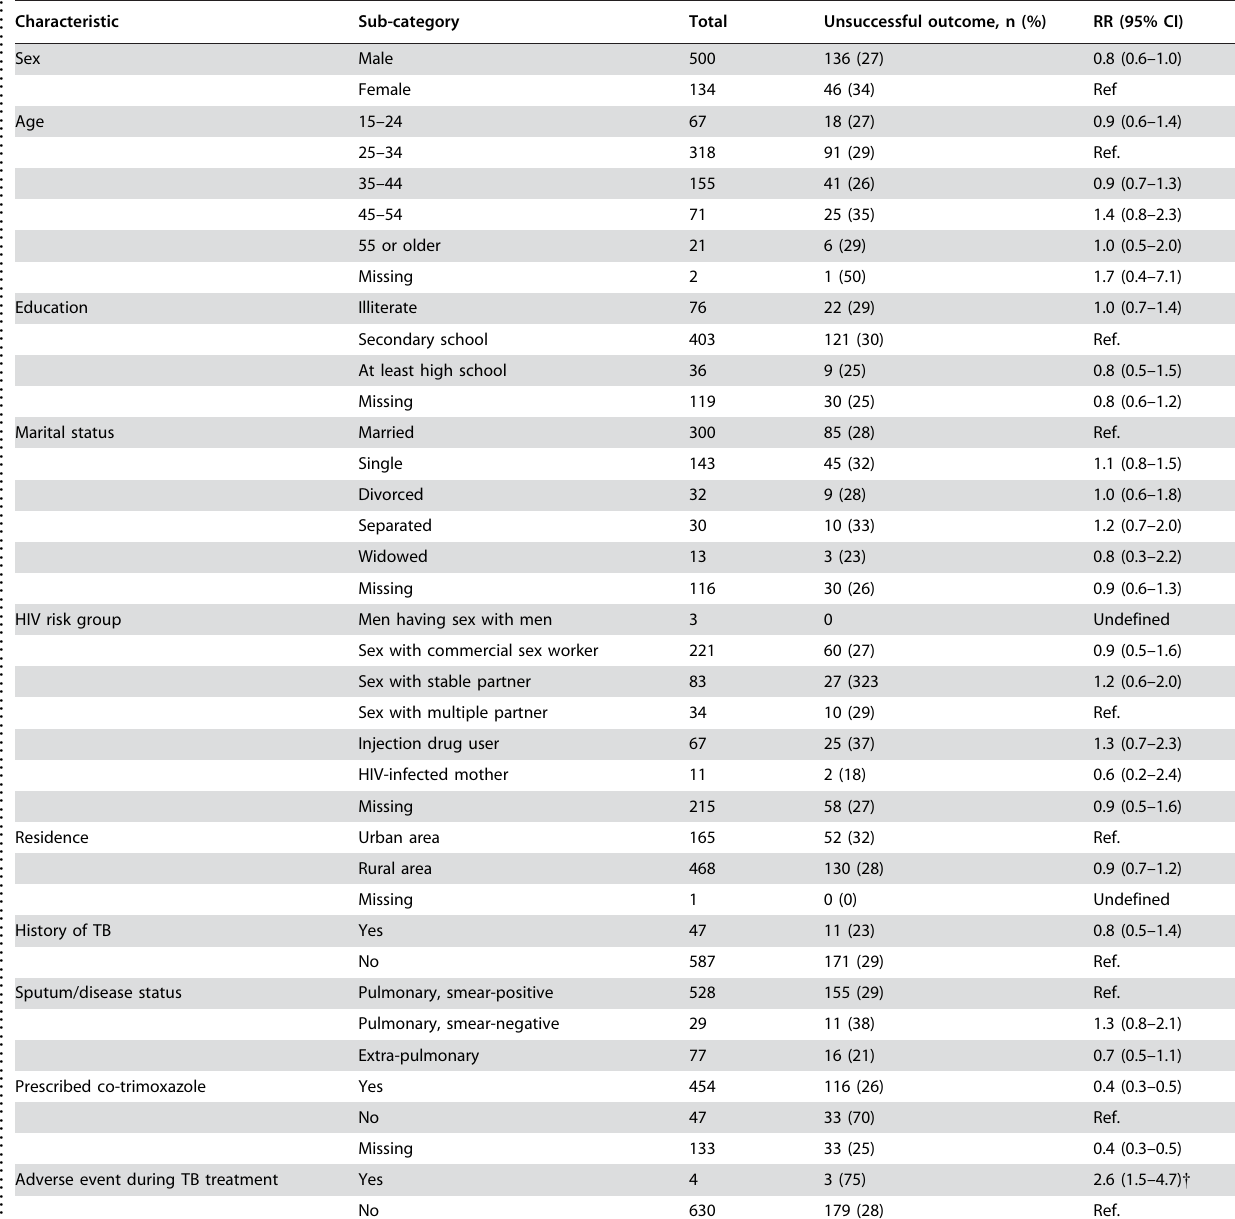
Table 3. Bivariate analysis of risk factors for unsuccessful TB treatment outcomes among HIV-infected TB patients – An